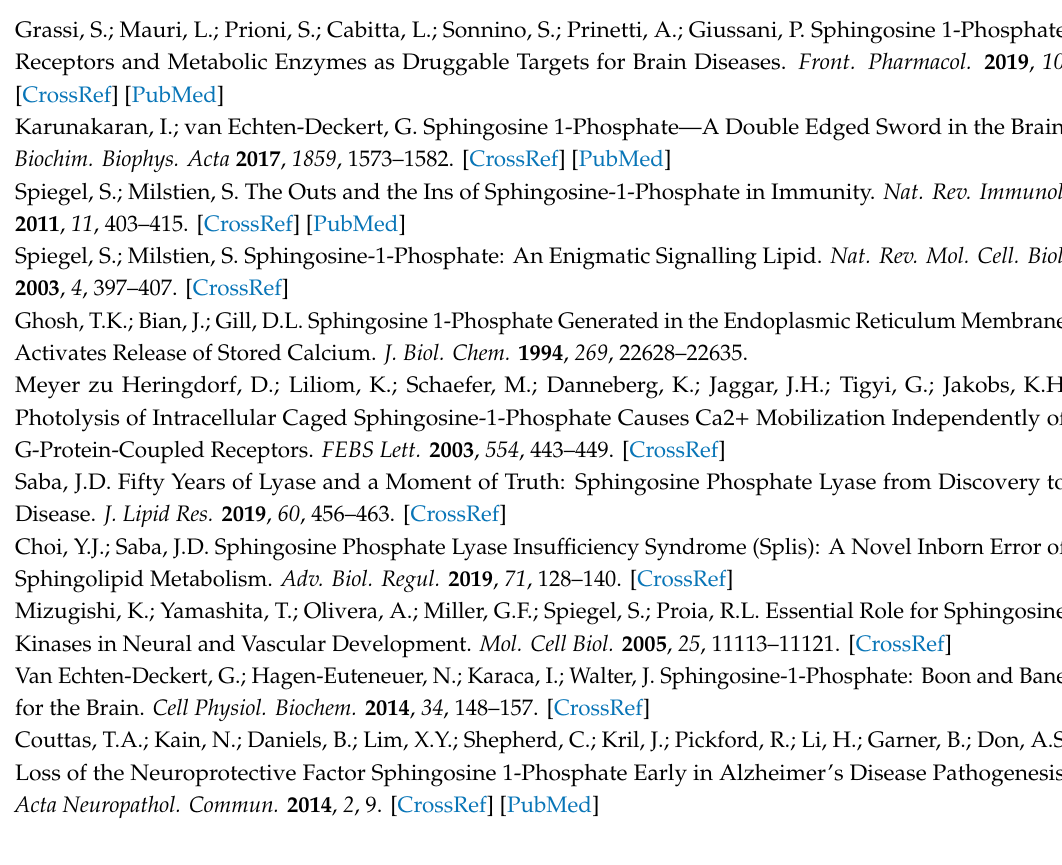
Figure S1: Neural-specific depletion of SGPL1; Figure S2: SGPL1 deficiency has no e ff ect on acetylaztion of Histone3 at lysine 14 and 18; Figure S3: BAPTA-AM treatment has no e ff ect on tau S262 / 356 hyperphosphorylation in the brain of SGPL1 fl / fl / Nes